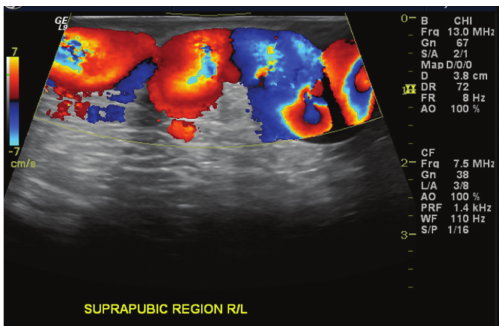
Figure 1: Duplex ultrasound of suprapubic venous plexus. Note the tortuosity in the vessel and the continuous flow beneath the ultrasound probe.